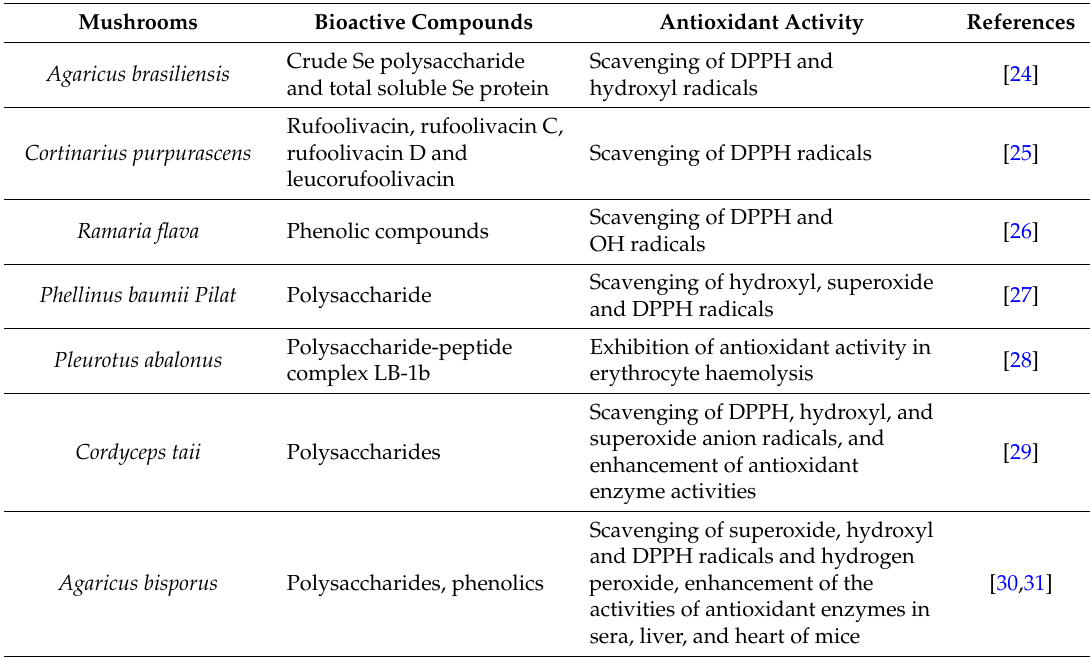
Table 1. Antioxidant activities of some